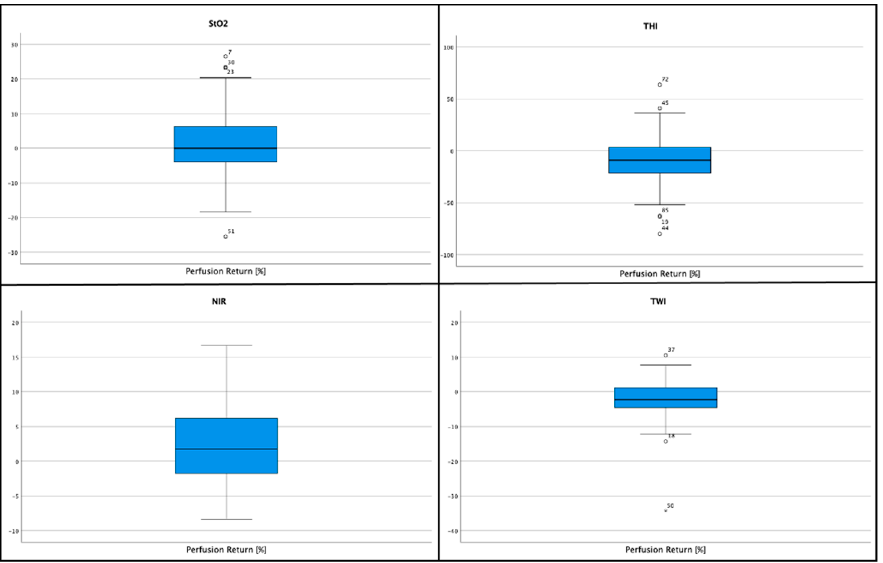
Figure 4. Boxplot diagrams for return-to-perfusion measurements for StO 2 , NIR, THI and TWI values obtained from the population with a non-pathological modified Allen’s Test.